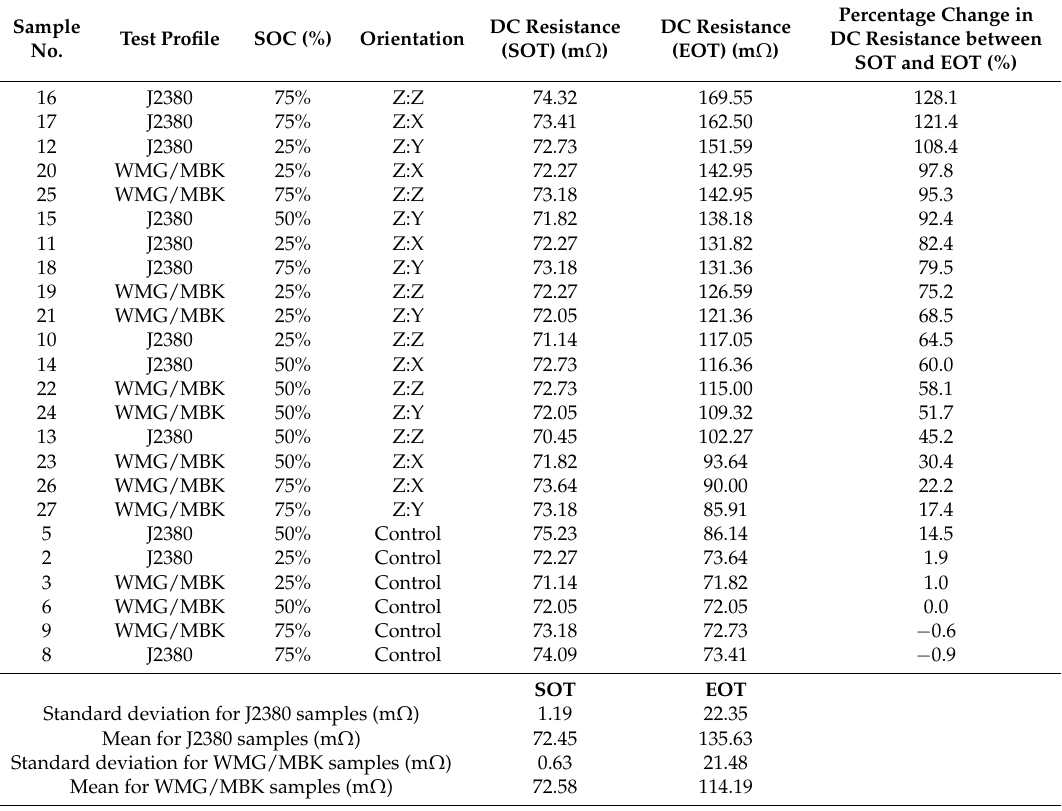
Table 10. Summary of change in pulse power performance